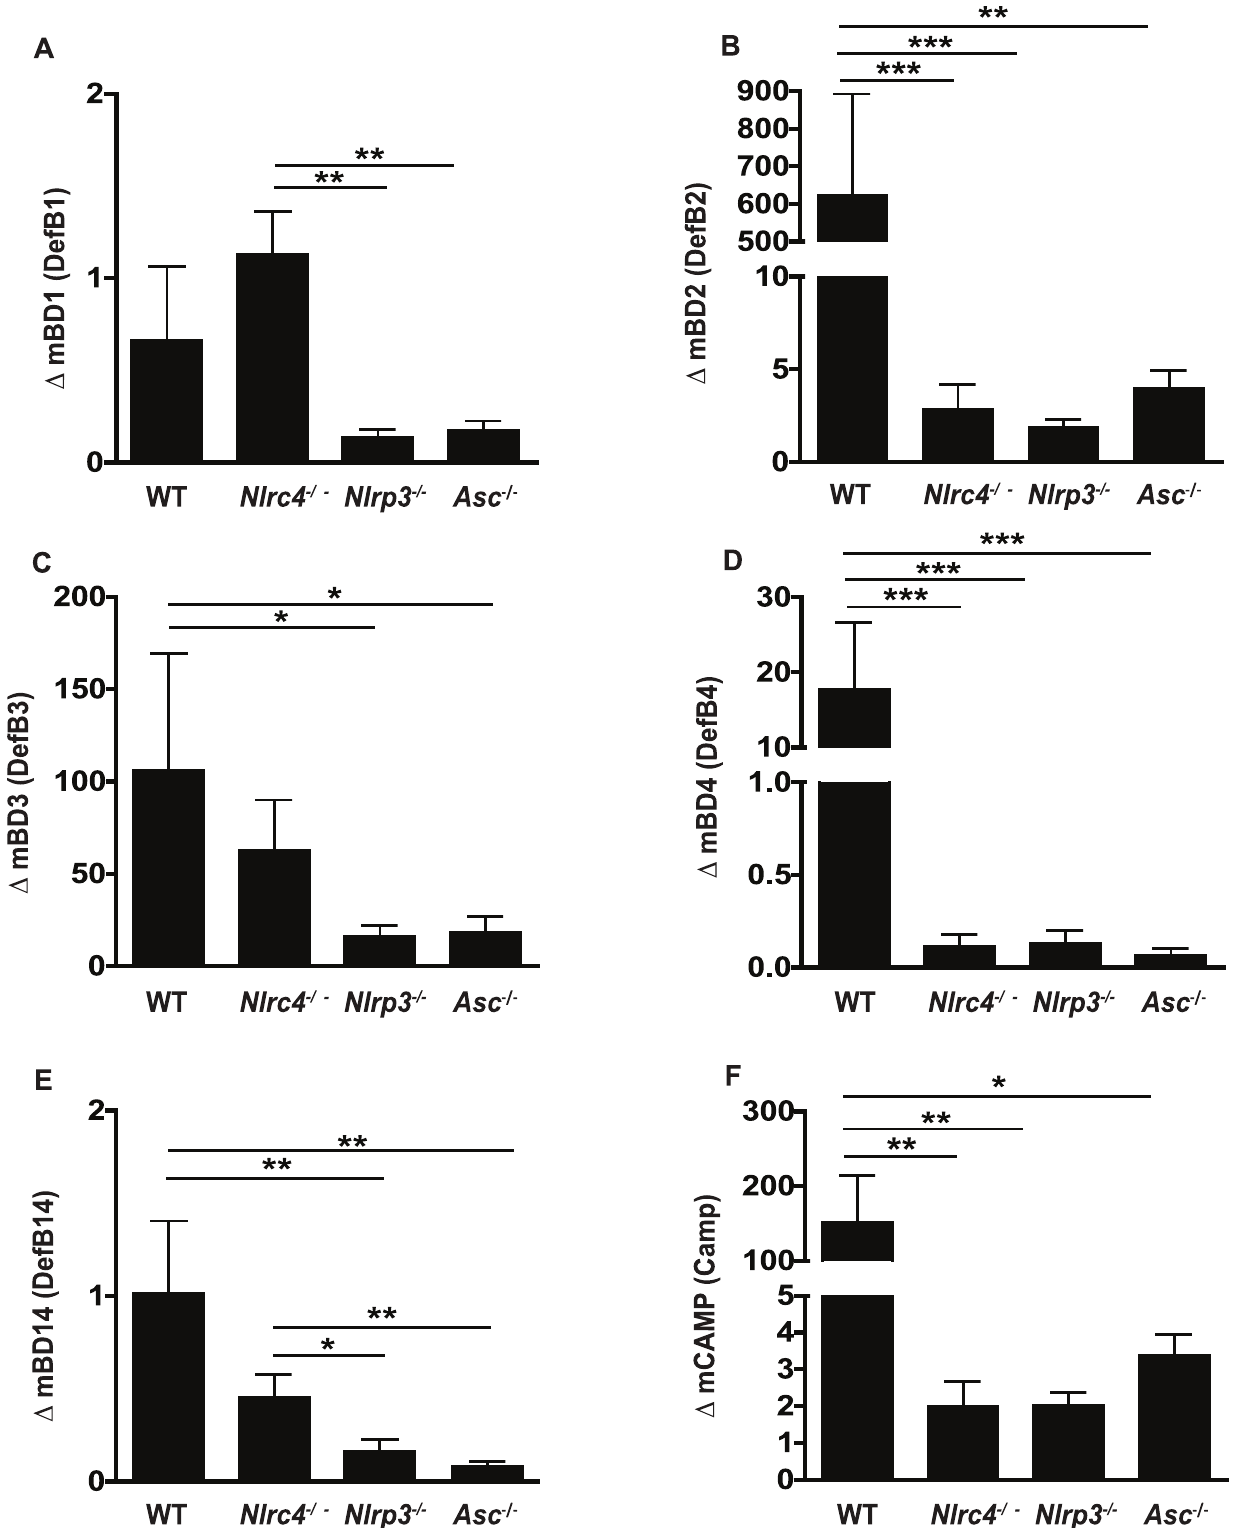
Figure 6. Antimicrobial peptide up-regulation in response to oral infection with Candidaalbicans is impaired in NLRP3, ASC and NLRC4 - deficient mice. Expression of the antimicrobial peptides (A) murine b -defensin 1, (B) murine b -defensin 2, (C) murine b -defensin 3, (D) murine b -defensin 4, (E) murine b -defensin 14, and (F) CAMP in buccal mucosal tissues from WT, Nlrc4 2 / 2 , Nlrp3 2 / 2 , and Asc 2 / 2 mice after 72 h of infection with Candida albicans . (*** P # 0.001; ** P # 0.01; * P # 0.05).